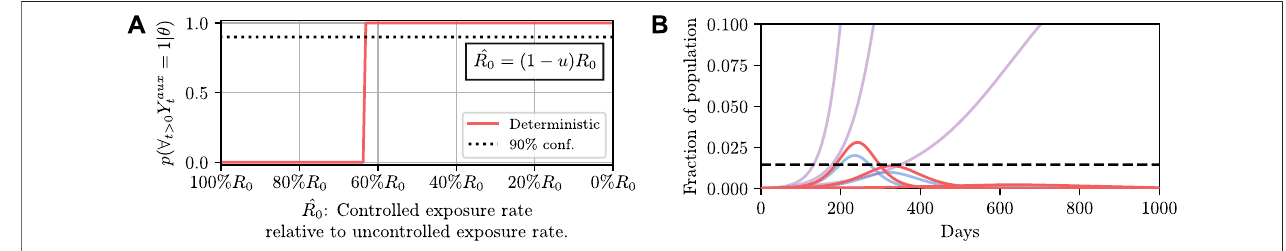
FIGURE 4 | Here we demonstrate planning using the deterministic SEI 3 R model. (A) shows, in red, the probability that the constraint is met using the deterministic simulator. The probability jumps from zero to one at a value of approximately u (cid:1) 0.37. (B) then shows trajectories using three salient parameter values, speci fi cally, u (cid:1) [ 0 . 3 , 0 . 37 , 0 . 45 ] . Each parameter value corresponds to more control than the previous, and is evident as the peak infection fraction drops from approximately 0.03 with u (cid:1) 0.3, to 0.014 with u (cid:1) 0.37 and almost zero with u (cid:1) 0.45. These values were selected as values just below, on, and above the threshold seen in (A) . We reuse the colour scheme de fi ned in Figure 2A